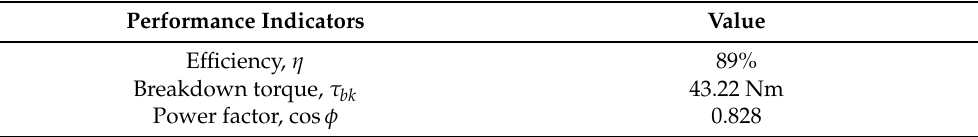
Table 6. Performance of IM based on the initial design